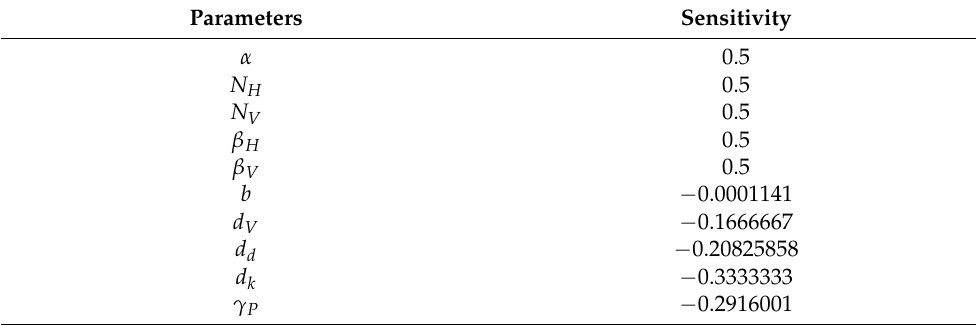
Table 4. Sensitivity indices R 0 p evaluated at the baseline parameter values of Table